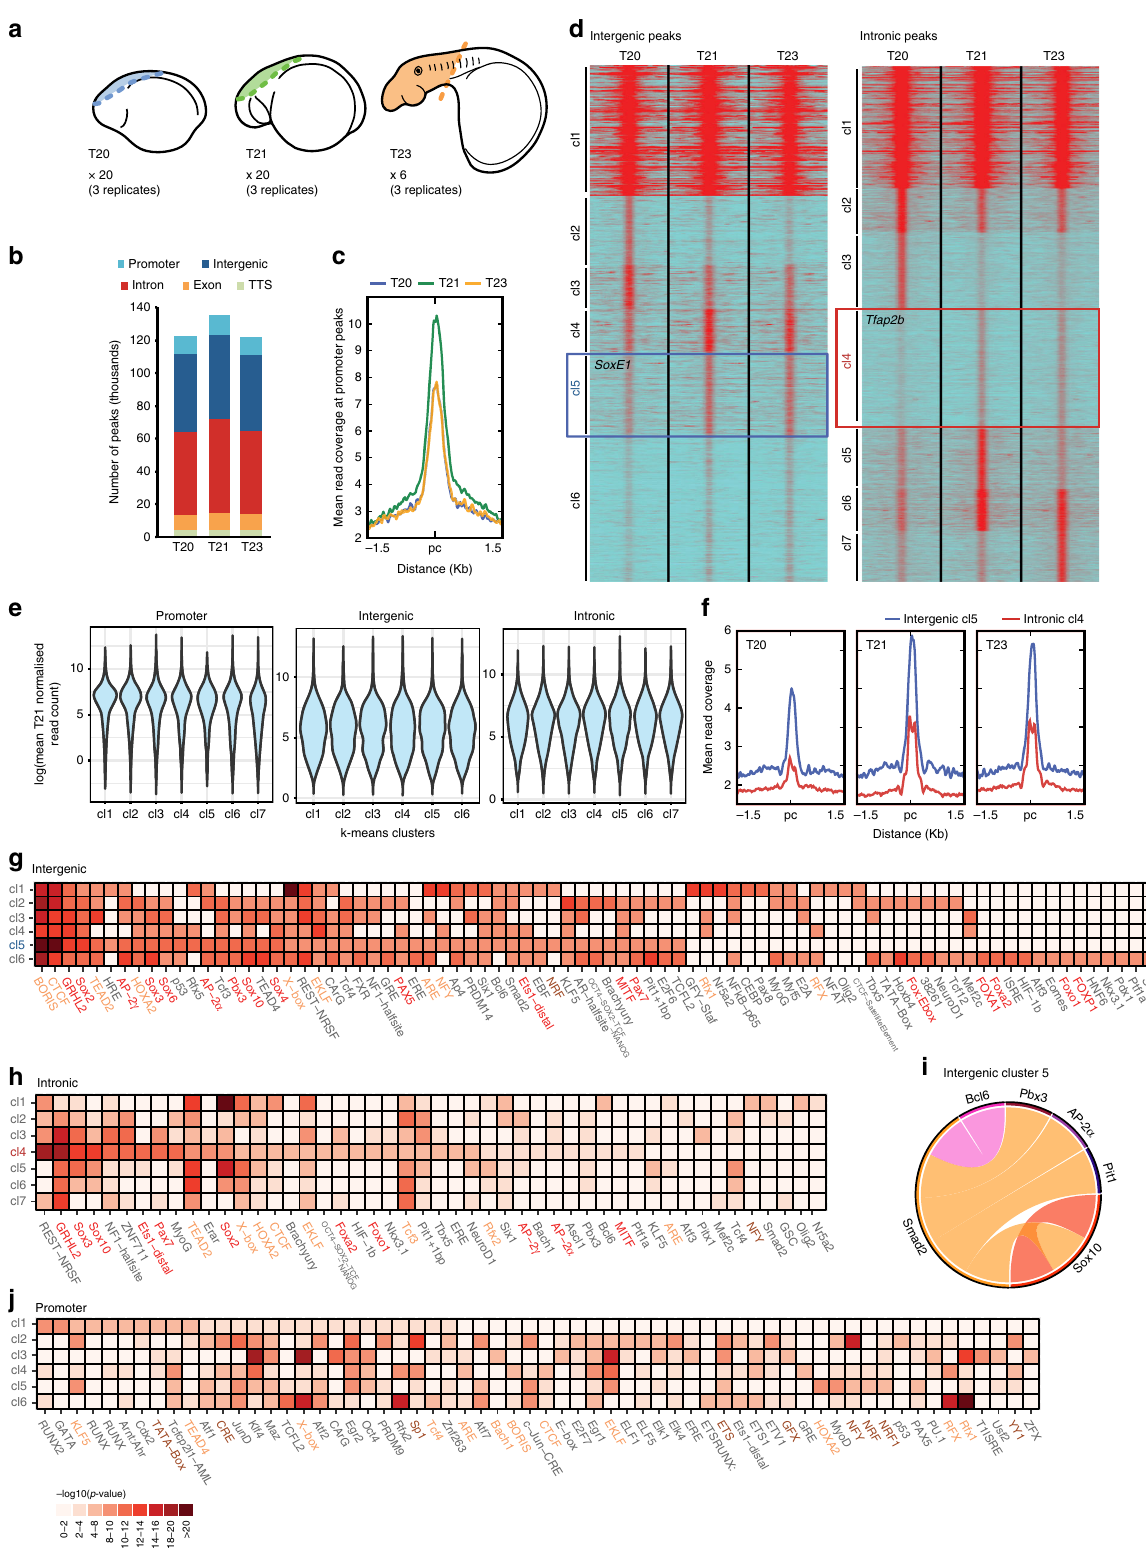
K -means clustering of the ATAC-seq signal over consensus showing, as expected, that enriched gene expression correlated peaksets (8998 intergenic; 17,908 intronic; 1860 promoter) with increased promoter accessibility (Fig. 2c).In addition, when revealed the dynamics of chromatin accessibility genome-wide all promoter peaks were taken into consideration (i.e., 10,286 over the course of development (Fig. 2c – f). The ATAC-seq signal annotated and novel promoter peaks), gene expression associated associated with promoter peaks was highest at T21 for all clusters with promoter peaks was higher and less variable than that NATURE COMMUNICATIONS| (2019) 10:4689